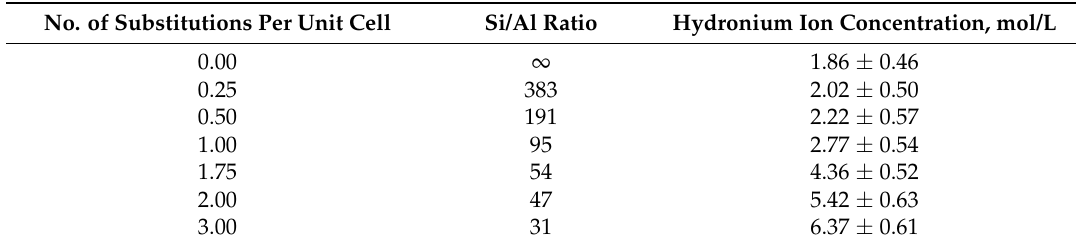
Table 1. Hydronium loading in membranes with increasing aluminum substitution levels. Uncertainties represent one standard deviation of the ion loading over 0.5 ns of